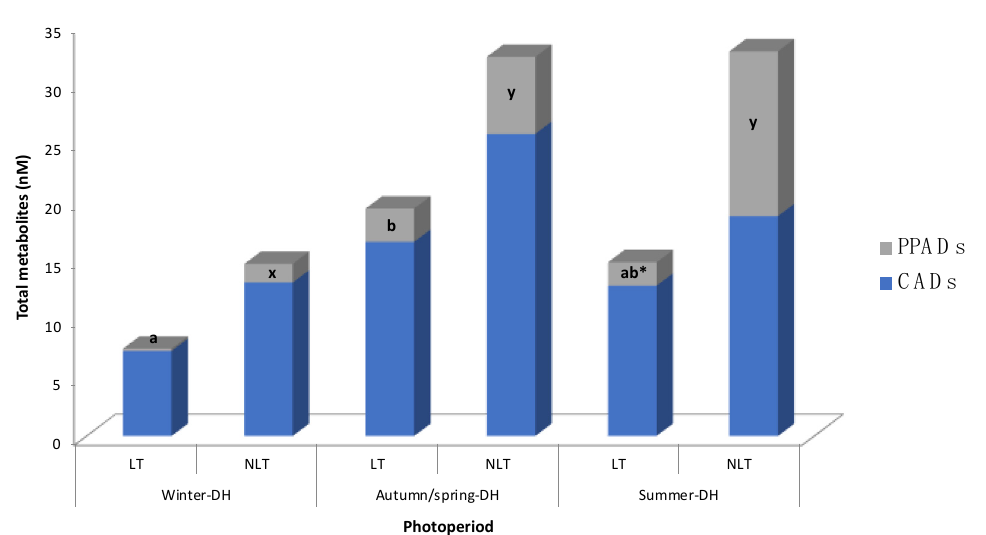
Figure 2. Distribution of (poly)phenolic metabolites in rat serum after 100 mg/kg bw/day administration of local (LT) or non-local (NLT) Ekstasis tomatoes and exposed to seasonal daylight schedules. * indicates statistical difference of PPADs concentrations ( p < 0.05) between LT and NLT ingestion within each photoperiod estimated by Student’s t -test. Values with different letters (a, b; for LT consumption) and (x, y; for NLT consumption) indicate different PPADs concentrations ( p < 0.05) between the photoperiods, estimated by one-way ANOVA. CADs concentration had no statistical difference by one-way ANOVA or Student’s t -test. Abbreviations: CADs, cinnamic acid derivatives; DH, daylight hours; PPADs, phenylpropanoic acid derivatives.